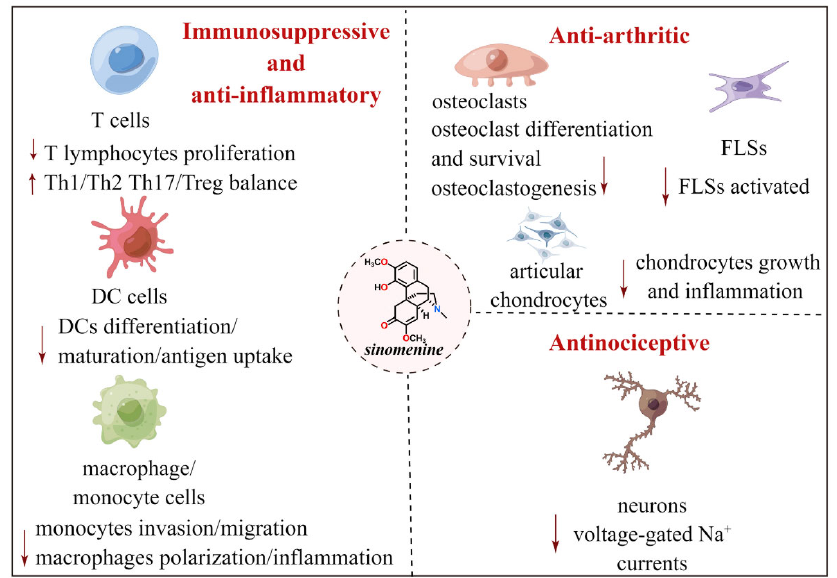
Figure 2. Molecular mechanisms of sinomenine for treatment of RA. Sinomenine exhibits its therapeutic effects on RA by modulating several key immune responses and inflammatory pathways, attenuating inflammation, alleviating pain, and inhibiting bone and joint destruction.